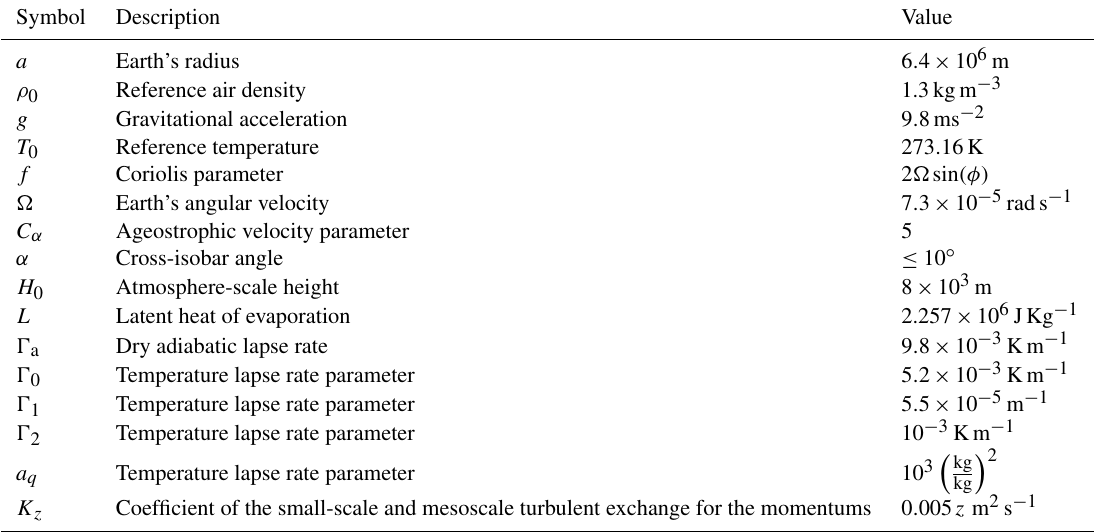
Table 1. Atmosphere model